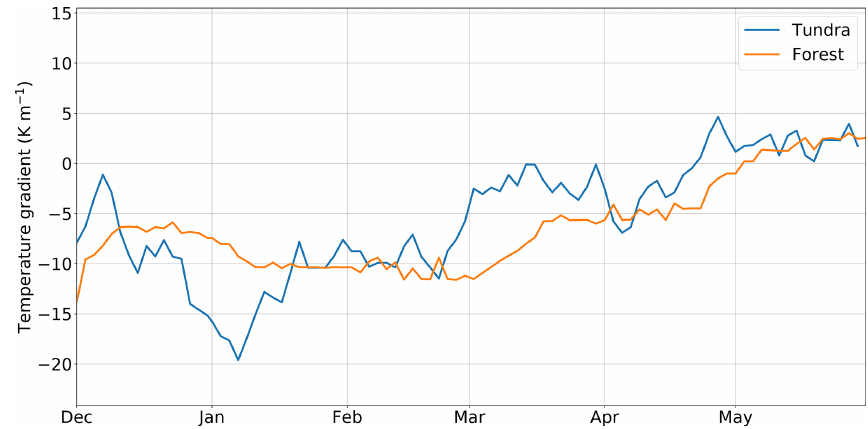
Figure 11. Temperature gradient at the base of the snowpack for winter 2017–2018 at TUNDRA and FOREST. At TUNDRA, measurements were made at 11 and 21cm, while the measurement heights were 4 and 14cm at FOREST. Note that the measurement interval was 2d; thus the peak gradients are likely to be larger than shown here. Negative gradients indicate higher temperatures close to the ground surface than those in higher snow